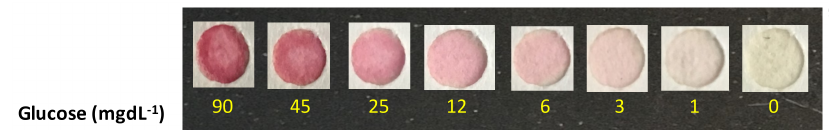
Figure 4. Naked-eye visual scale obtained for glucose detection.